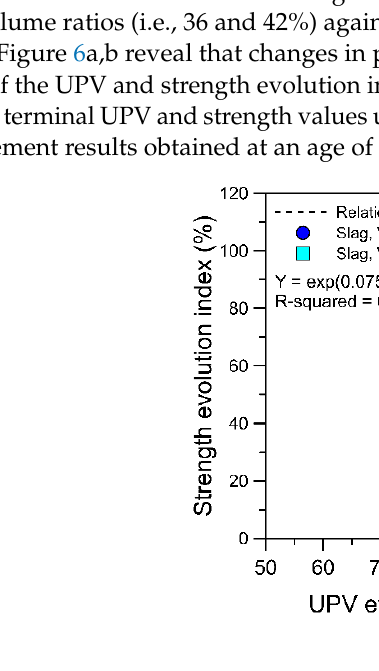
Figure 7. Relationship between the UPV and strength evolution index of normal and pozzolanic concrete. 3.4. A Unified Equation for the Relationship between UPV and the Strength Evolution Index The aforementioned results indicated that the adoption of various mixture propor- tions in this study, namely with respect to the water-to-cementitious material ratio, paste volume ratio, sand–aggregate ratio, type of aggregate source, and amount of pozzolanic